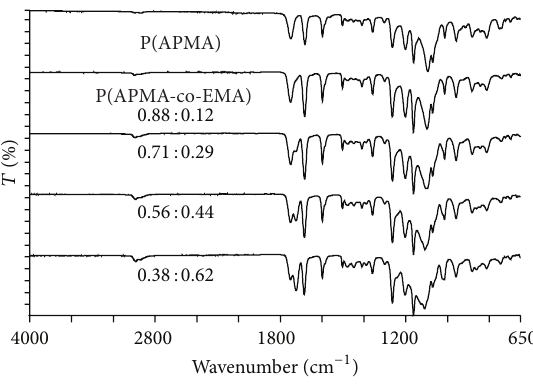
Figure 2: IR spectra of homopolymer and copolymers. Table 2: KT parameters for APMA-co-EMA copolymer system.